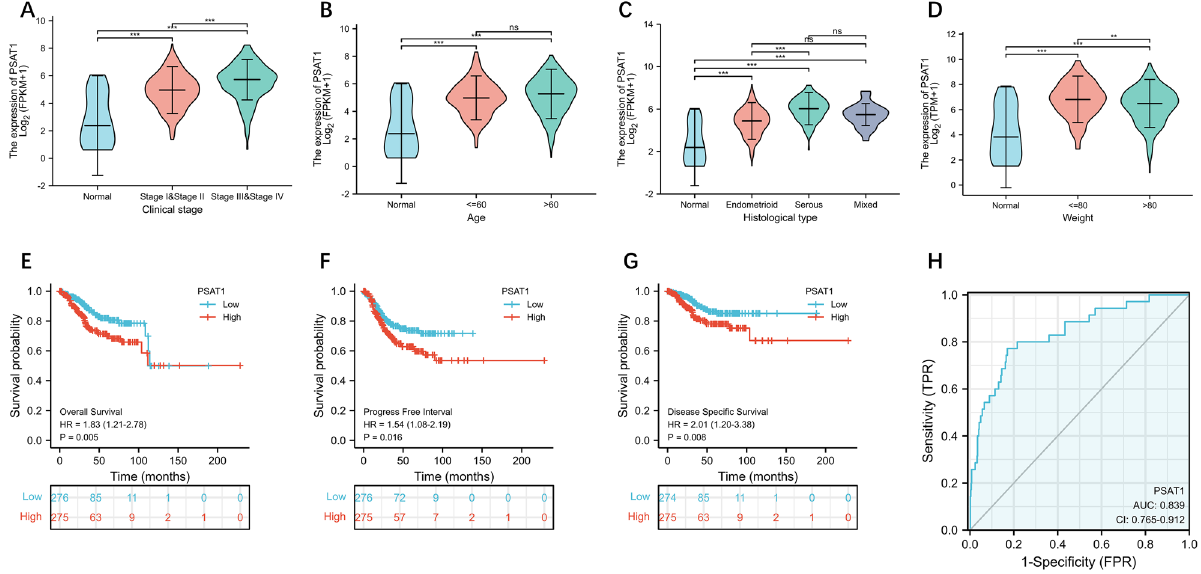
Figure 3. The prognostic and diagnostic value of PSAT1 expression in UCEC. Association of PSAT1 expression level with clinical stage ( A ), age ( B ), histological type ( C ) and weight ( D ) in UCEC. Survival curves of OS ( E ), PFI ( F ) and DSS ( G ). ( H ) A diagnostic ROC curve analysis evaluating the performance of PSAT1 for UCEC diagnosis. *p < 0.05, **p < 0.01, ***p < 0.001, ns, P > 0.05.